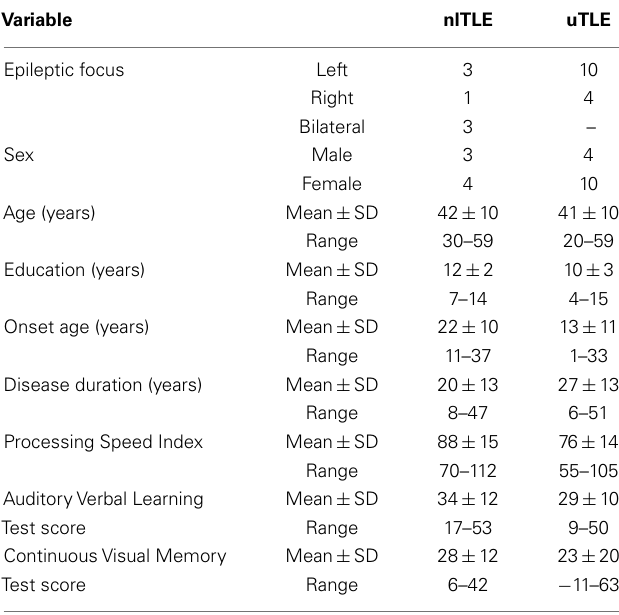
Table 1 | Demographic and clinical data for study patients